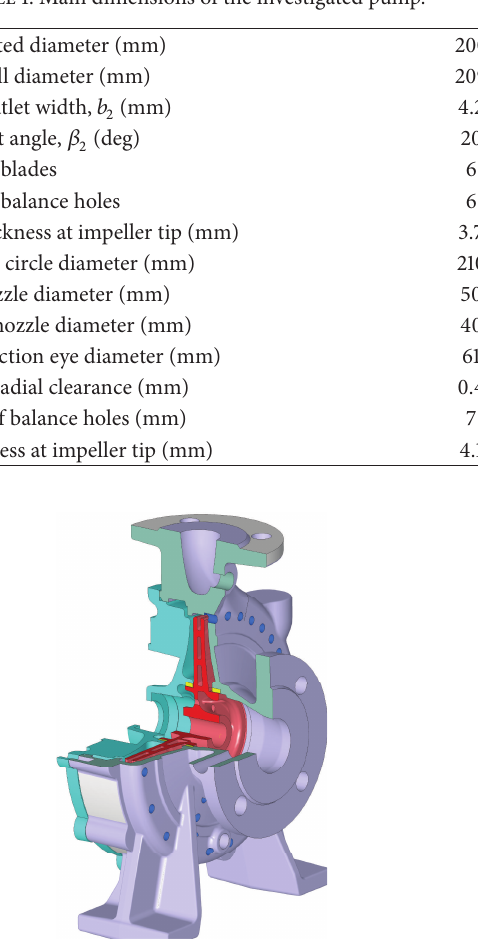
Figure 2: Cutaway drawing of the pump